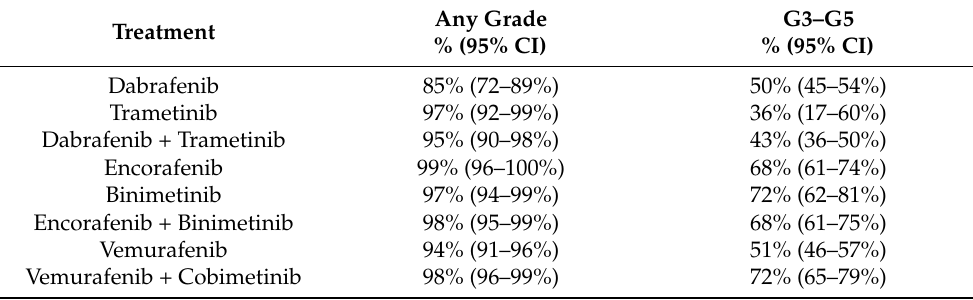
Table 1. Overall incidence of any grade and G3–G5 adverse events according to treatment.